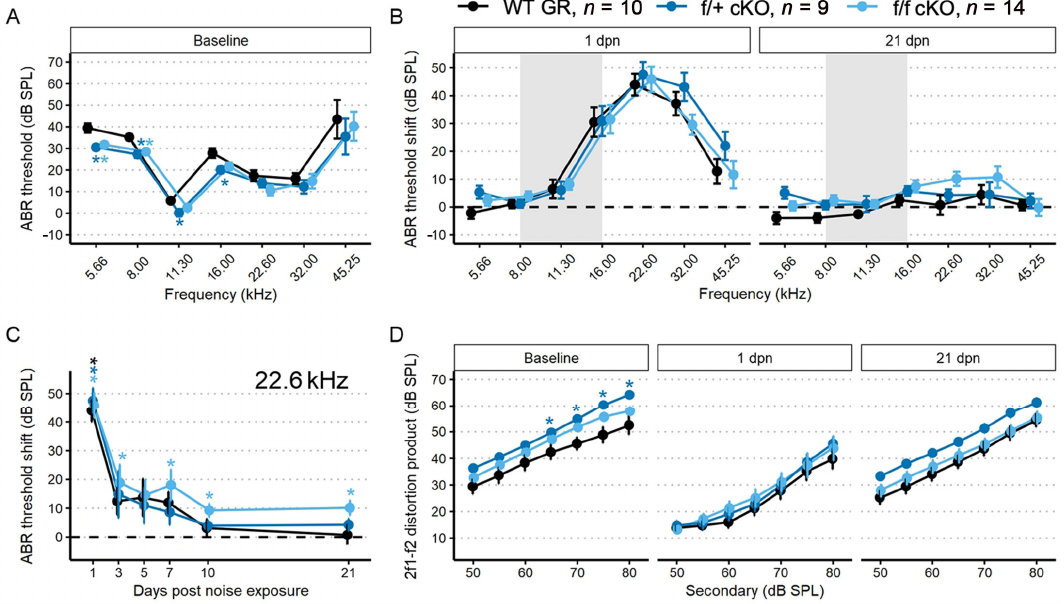
Figure 5. ABR threshold and DP amplitudes (mean ± SEM) were measured in 2–4-month-old mice ( n = 33) after supporting cell GR ablation and 94 dB SPL mild noise exposure. ( A ) Baseline ABR thresholds from low-to-high recording frequency. Data from f/+ cKO GR mice are blue and f/f cKO GR mice are light blue. Ablation of GR resulted in a decrease of ABR thresholds. ( B ) ABR threshold shift plots following 94 dB SPL exposures at 1 and 21 dpn. The grey bar indicates 94 dB SPL exposing noise bandwidth. Baseline at zero is indicated by a dashed line. While all mice recover from the noise-induced TTS, the f/f mice do not regain baseline sensitivity except at 45.25 kHz. ( C ) ABR threshold shift with 22.6 kHz sound stimulus along dpn, demonstrating lack of full threshold recovery of tamoxifen-treated f/f mice. ( D ) DP amplitudes with f2 = 22.6 kHz sound stimulus at baseline, 1, and 21 dpn. At 1 dpn, all groups show a depressed 2f1–f2 amplitude at 22.6 kHz. While a trend occurs with f/+ mice recovering slightly more amplitude than control (no tamoxifen) or f/f mice, no statistical significance was found. Overall, recovery of DP amplitudes by 21 dpn nearly returned to baseline values, with some small permanent loss at the lowest sound intensities. Asterisks indicate p < 0.05 difference to control (no tamoxifen). In all panels, the color-coded asterisks are coupled with the similarly color-coded data for each genotype group (plotted along each colored line) and indicate significant difference from control (no tamoxifen) of that group at p < 0.05. Two-way ANOVA tests were used for statistical assessments with statistical significance assigned to p < 0.05.